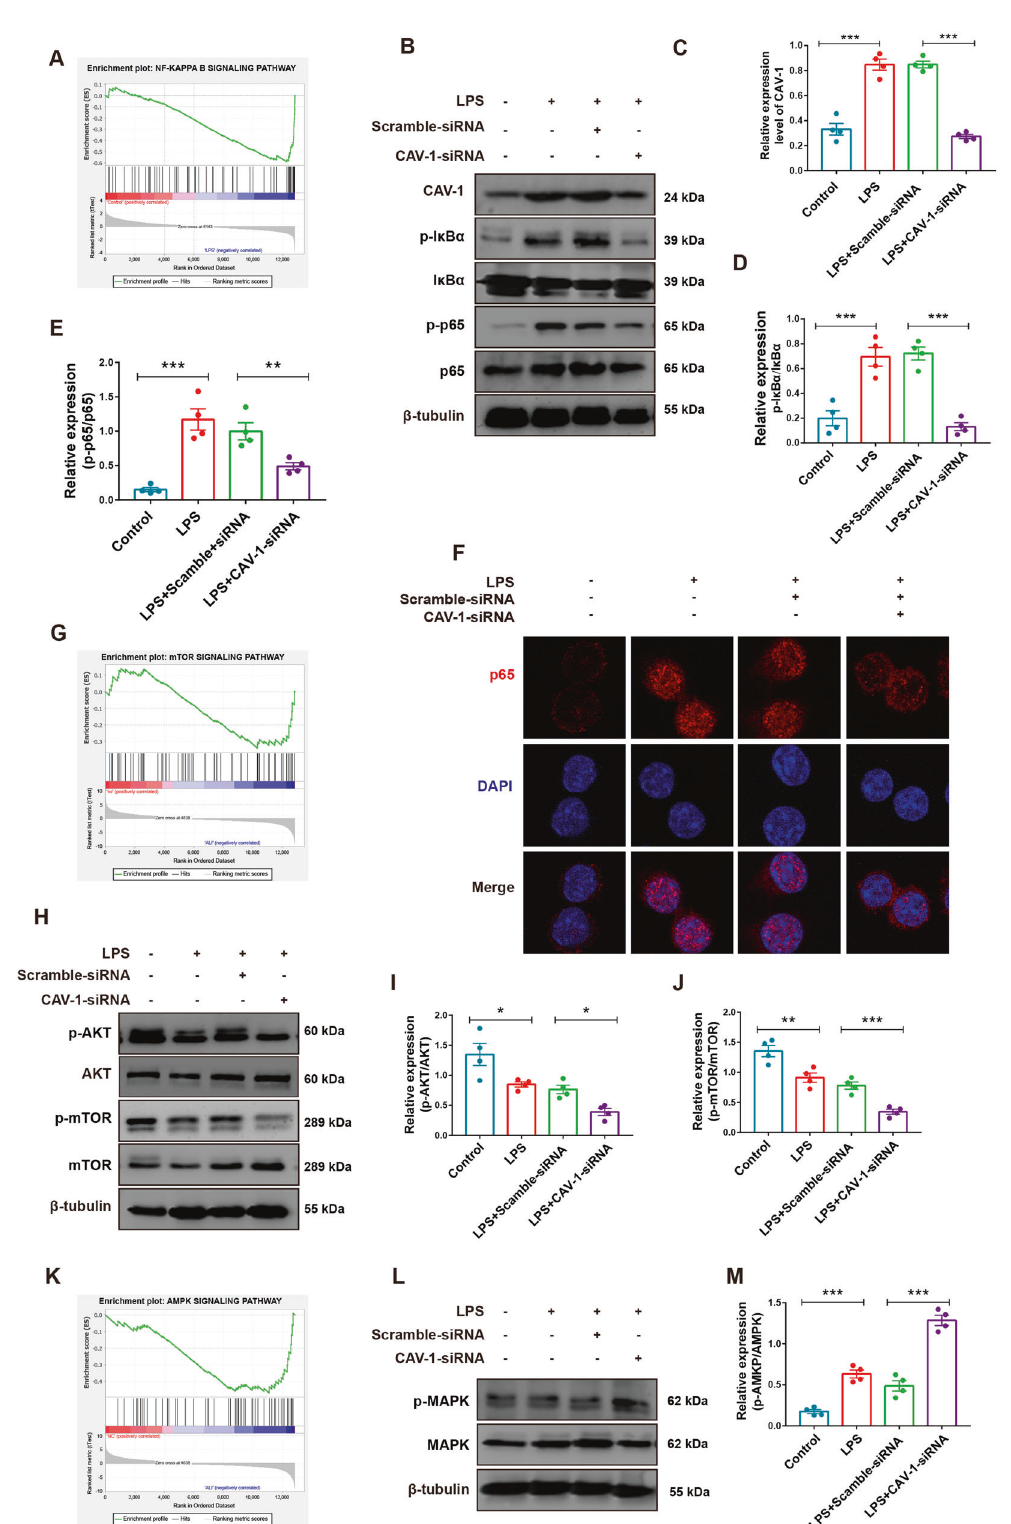
Fig. 7 Knockdown of CAV-1 inhibited autophagy-related signaling pathways in BMDMs. A GSEA analysis of NF- κ B signaling pathway in ALI samples. B Western blotting analysis of CAV-1, p-I κ B α , I κ B α , p-NF- κ Bp65, and NF- κ Bp65 protein levels in BMDMs. C – E Quanti fi cation of these protein bands. F Confocal laser immuno fl uorescence showed NF- κ Bp65 nuclear translocation in BMDMs from different groups (magni fi cation ×63). G GSEA analysis of mTOR signaling pathway in ALI sample. H , L The expression of p-AKT, AKT, p-mTOR, mTOR, p-AMPK, and AMPK were detected by western blotting in BMDMs . I , J , M Quanti fi cation of these protein bands. K GSEA analysis of AMPK signaling pathway in ALI samples. Results were represented as mean ± SEM ( n = 4, * p < 0.05, ** p < 0.01, *** p < 0.001).